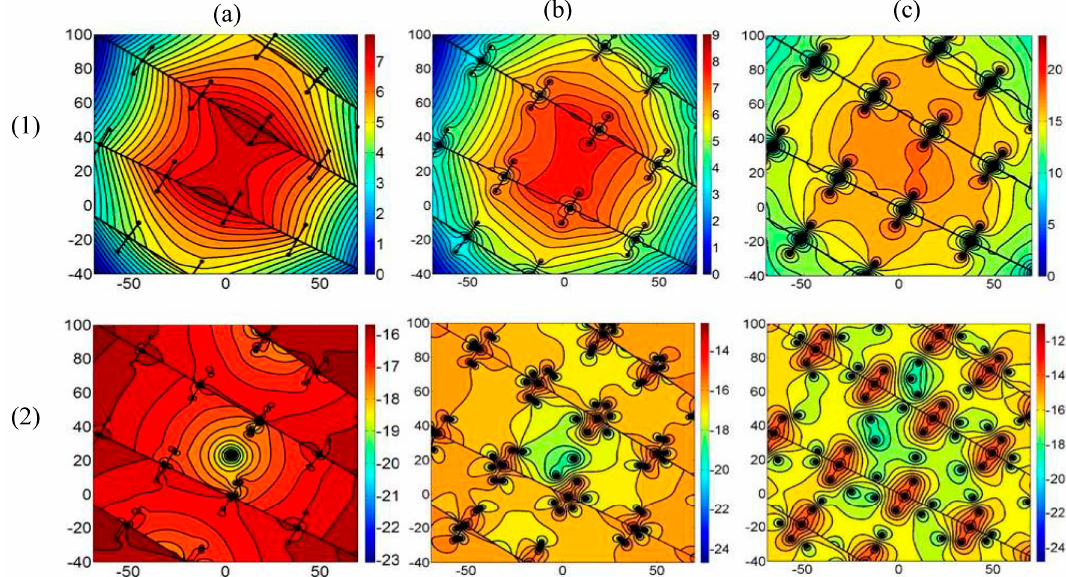
Figure 11. ( a – c ) Row 1: Pressure contour maps (in MPa) after 1 month drainage for the same central region of Figure 9d, now including flow through micro-cracks normal to the main fractures. Dipole strength of ( a ) is scaled to match hydraulic conductivity of the main fractures. Cases ( b , c ) are respectively 5 and 10 times stronger. ( a – c ) Row 2: Velocity field (log scale in m · s − 1 ) for cases a-c in Row 1. Local velocities are higher near the micro-crack tips when conductivity is high. Overall area drained stays constant.